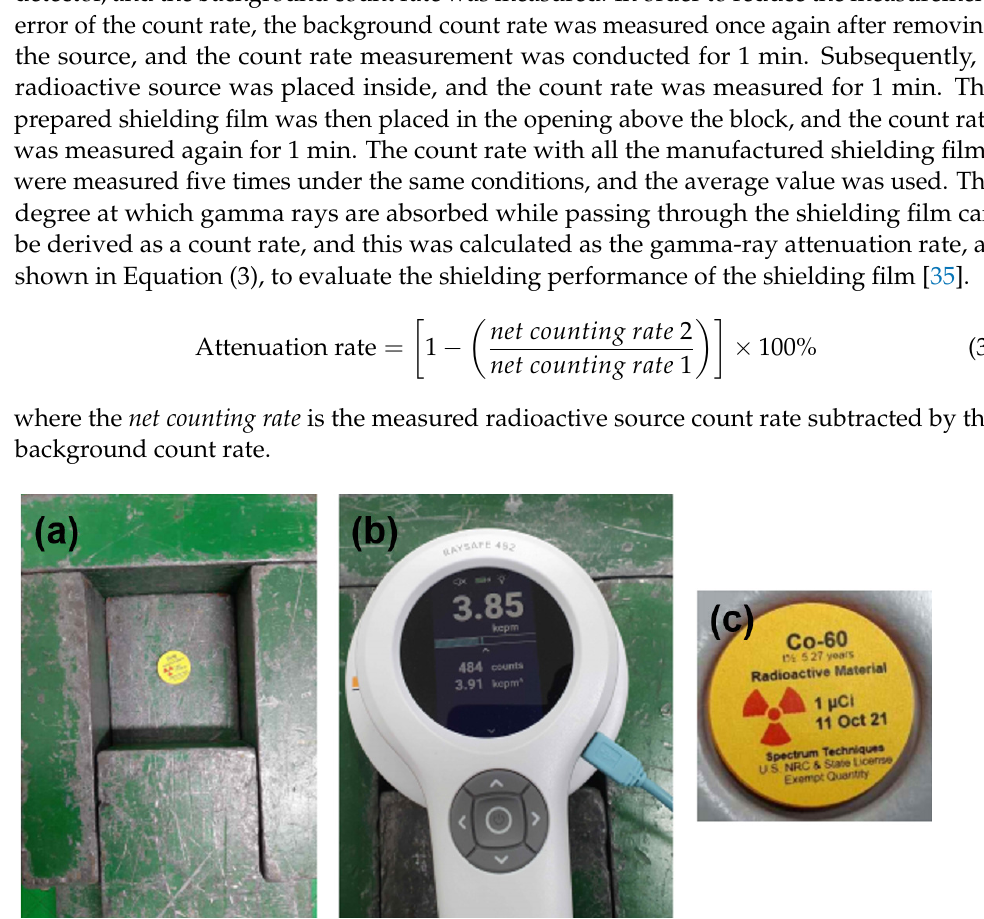
Figure 1. Gamma-ray measurement method: ( a ) Block-to-block external dose; ( b ) Gamma-ray dosimeter; ( c ) Co-60 source.